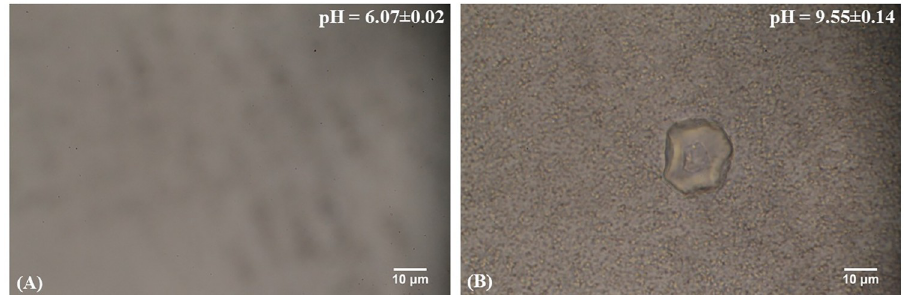
Fig 1. Image of crystals induced by SPMAP09 in AU at day 0 (A) and day 3 (B) (400X and scale bar,10 μ